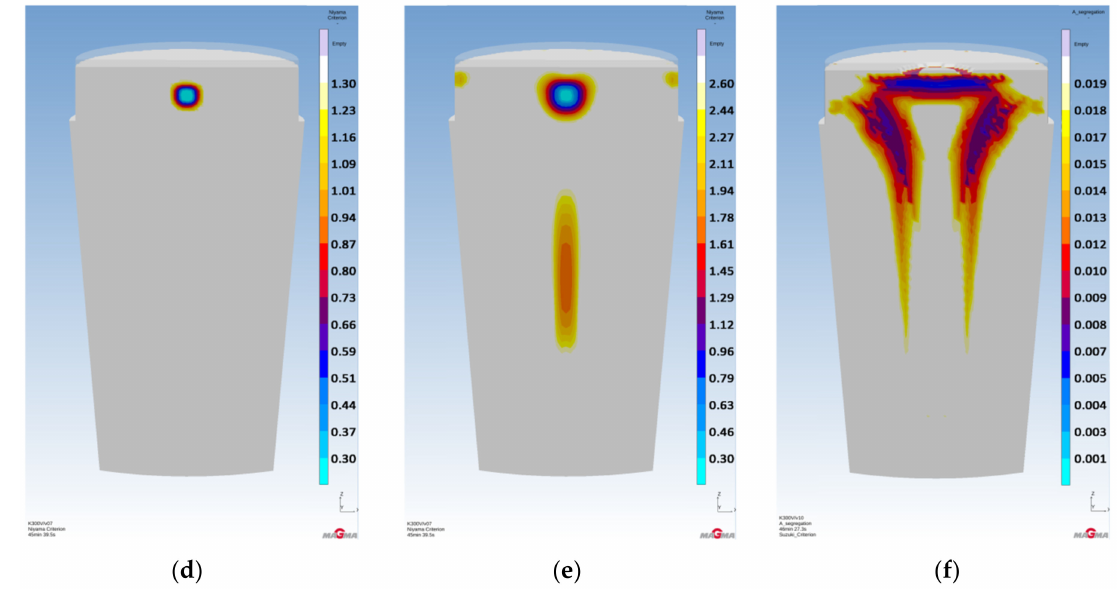
Figure 6. The results of criteria: ( a ) Soundness %; ( b ) Gradient Time 25 min 4.6 s; ( c ) Total Porosity %; ( d ) Niyama 0.3–1.3 K 1/2 s 1/2 mm − 1 ; ( e ) Niyama 0.3–2.6 K 1/2 s 1/2 mm − 1 ; ( f ) A-segregation (Suzuki criterion) 0.0–0.019 K s − 1 ( µ m s − 1 ) 1.1